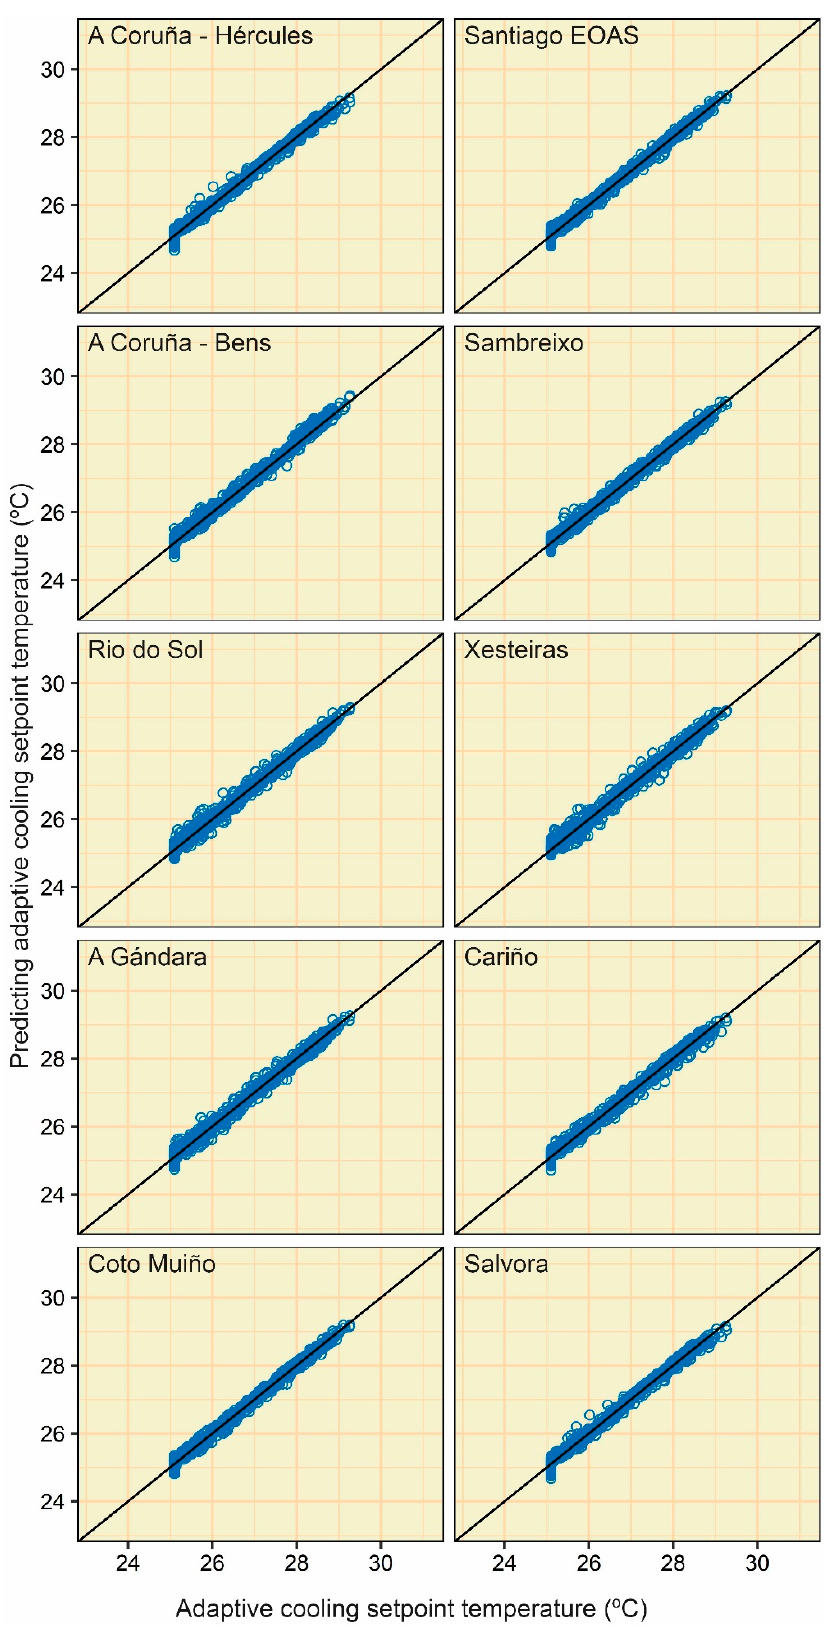
Figure A2. Point clouds between the actual and predicting adaptive cooling setpoint temperature values (category II) of the MLR (approach 1).